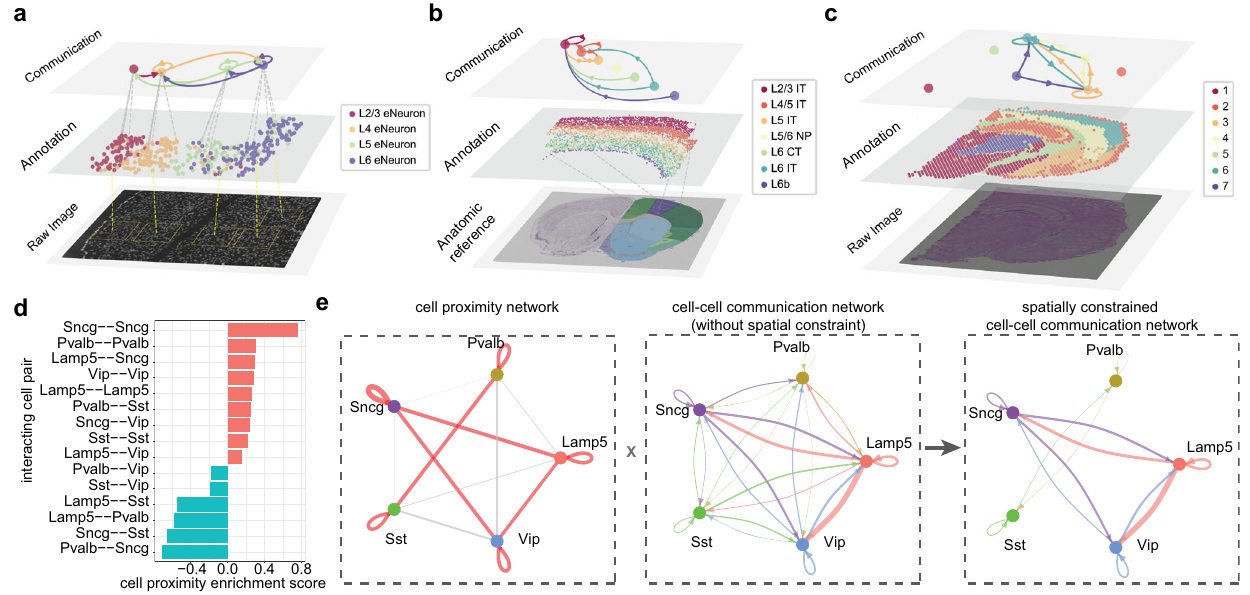
Fig. 7 | Multi-layered visualization for spatial data and inference of spatially constrained communication network. a – c Multi-layered visualization for three spatial transcriptomics datasets generated by different techniques seqFISH+ ( a ), MERFISH( b ),andVisium( c ).Eachplotincludestherawtissuesliceimage/anatomic reference (bottom), cell/spot annotation in space (middle), and the aggregated communication network with the top 10 links shown (top). The width of a link indicates the sum of communication strengths over all signi fi cant ligand-target pairs. See Supplementary Fig. 12 for the full aggregated networks. The bottom imagein( b )isthebrainanatomicreference(AllenMouseBrainAtlas,mouse.brain- map.org 56 and Allen Reference Atlas atlas.brain-map.org 57 ). d Bar plot showing the cell proximity enrichment scores for all pairwise interacting cell types. The cell proximity enrichment scores are calculated based on all 64 MERFISH slices. The